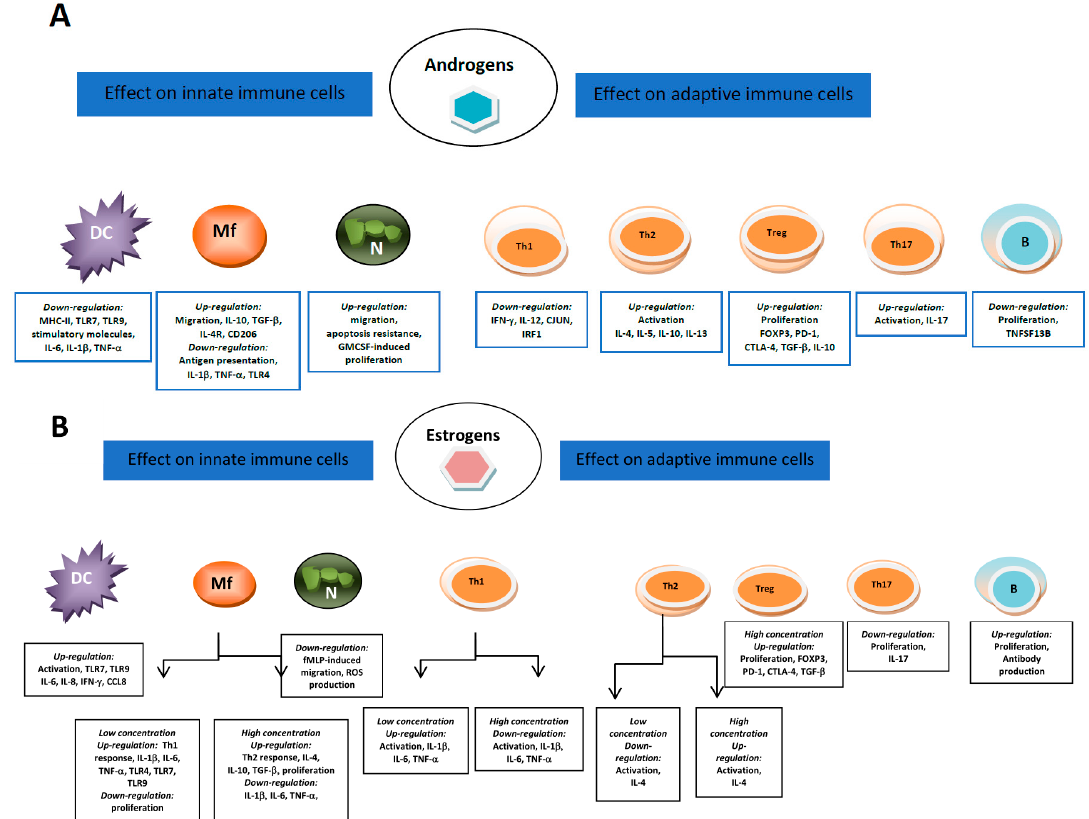
Figure 3. Effect of androgens and estrogens upon innate and adaptive immune cells. ( A ) Androgens mainly activate innate immune cell migration, apoptosis resistance, and inhibit antigen (Ag) presentation in correlation with downregulation of MHCII and costimulatory molecules. Androgens induce inhibition of Th1 and activation of Th2, Treg, and Th17 while downregulating B lymphocytes. ( B ) Estrogens induce various effects on innate immune cells depending on the estrogen dose; for macrophages (Mf) at low doses, Th1-type is induced, while at high concentrations, a Th2-type response is induced. Estrogens mainly activate dendritic cells (DC) while they exert inhibitory effects on neutrophils (N). Estrogens affect adaptive immune cells in a dose-dependent manner; at low concentrations, they activate Th1 and Th2, while inhibiting them at high concentrations. At high estrogen concentration, Treg are activated, Th17 inhibited, and B cells activated. THFS13B ― TNF superfamily member 13b ; IRF1 ― interferon regulatory factor 1.